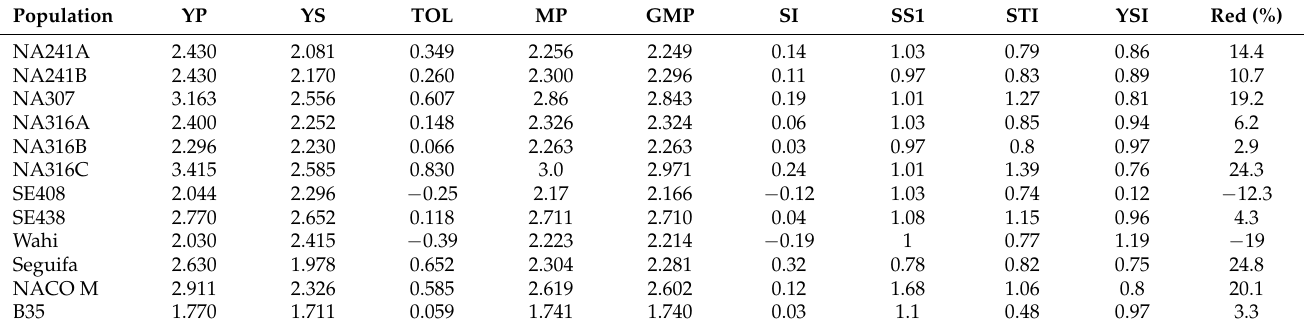
Table 11. Drought stress indices and yield under water-irrigated and water-stressed conditions. Population YP YS TOL MP GMP